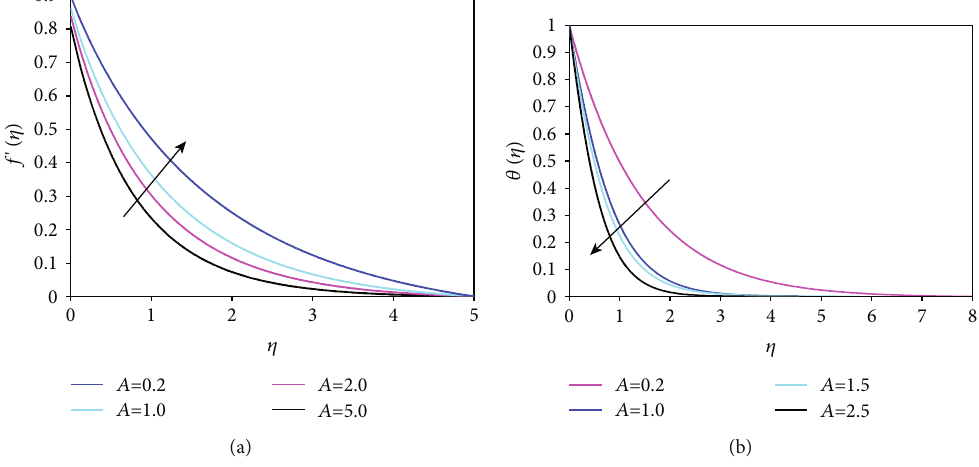
Figure 7: The graph of velocity and temperature for di ff erent values of curvature parameter ( A ).